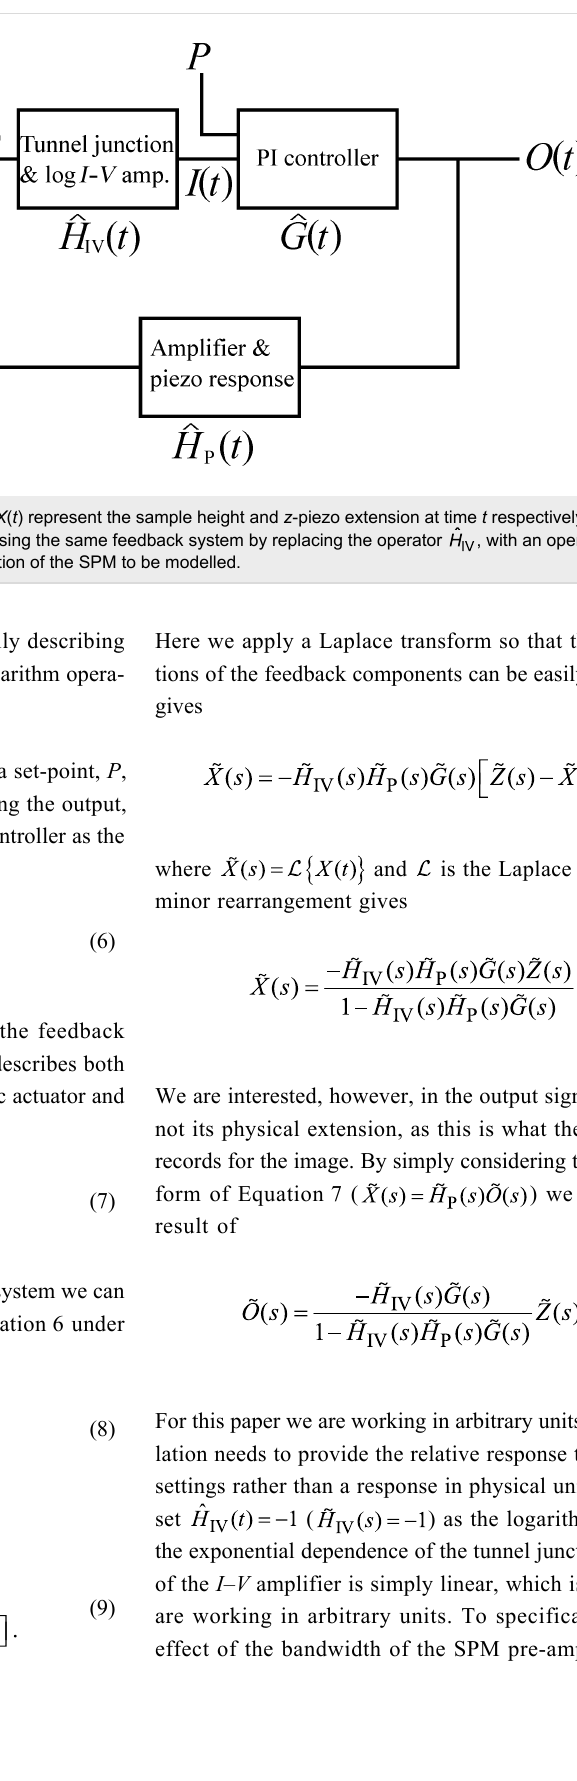
Figure 3: Schematic of an STM feedback loop. Z ( t ) and X ( t ) represent the sample height and z -piezo extension at time t respectively, and P is the set-point current. Other SPM systems can be modelled using the same feedback system by replacing the operator , with an operator that describes the tip–sample interaction and signal amplification of the SPM to be modelled.